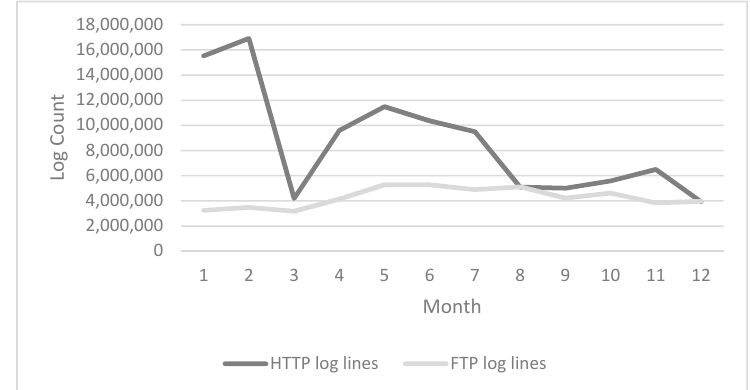
Figure 10. Monthly log distribution of the Physical Oceanography Distributed Active Archive Center (PO.DAAC).